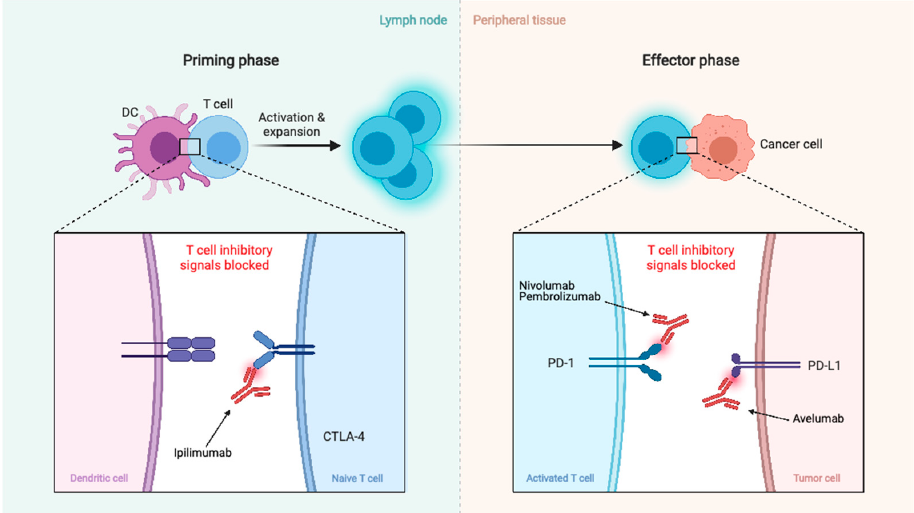
Figure 5. Summary of immunotherapy treatments. Blockage of CTLA-4, PD-1, and PD-L1 promotes an effective immune response against cancer cells.